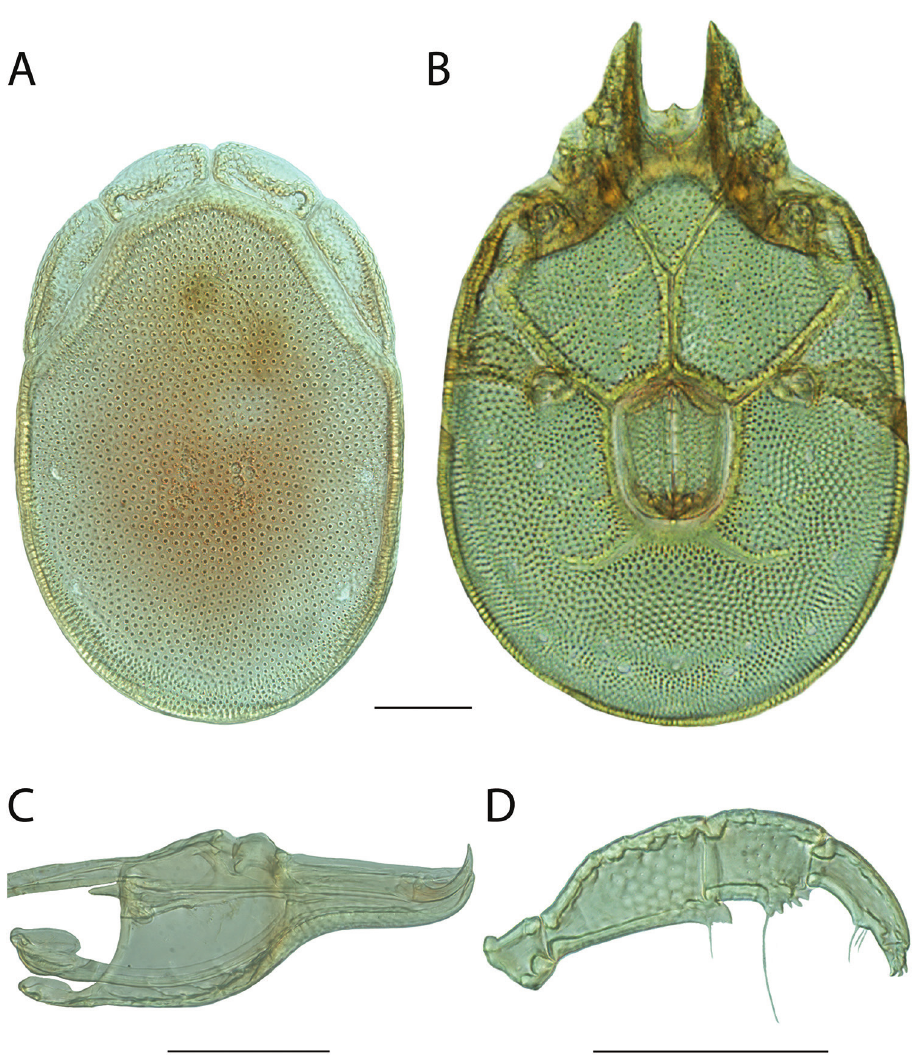
Figure 43. Torrenticola copipalpa sp. n. male: A dorsal plates B venter (legs removed) C subcapitulum D pedipalp (setae not accurately depicted). Scale = 100